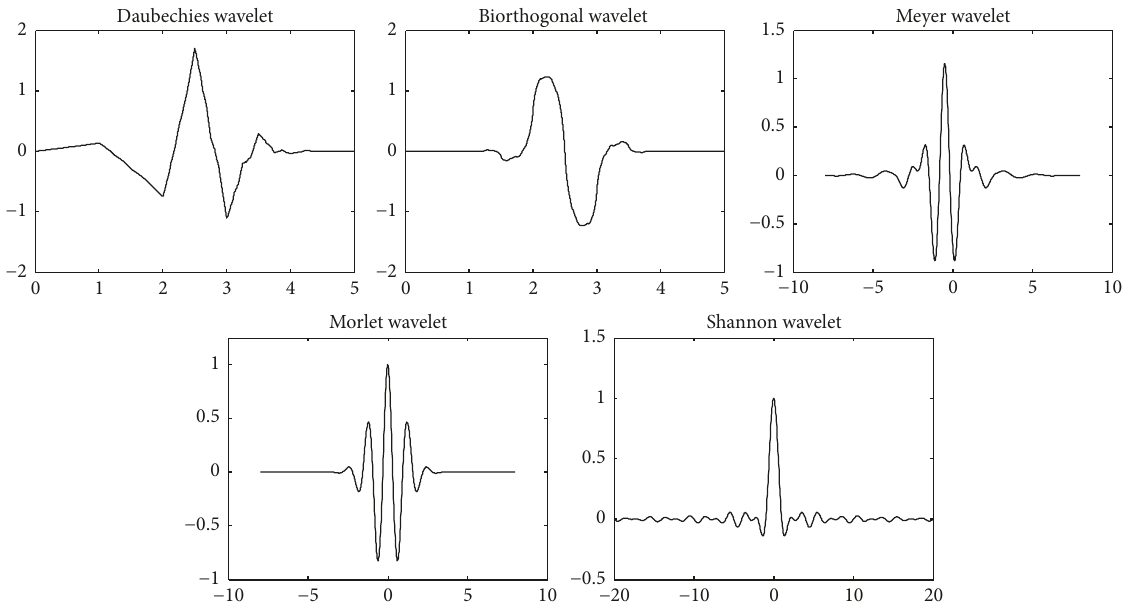
Figure 11: Selected examples of basic wavelet functions: Daubechies, Bior, Meyer, Morlet, and